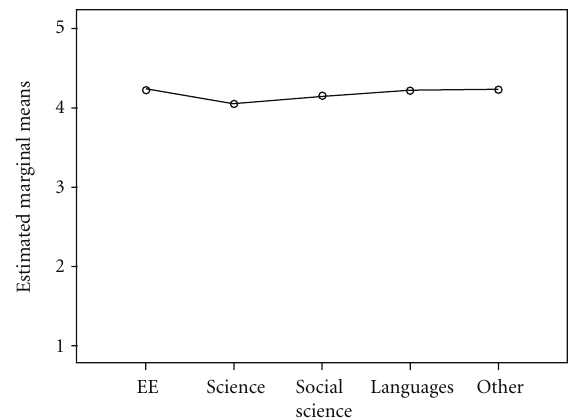
Figure 1: 3 Caring by connecting to others. Estimated Marginal means of 3 caring by connecting to others.